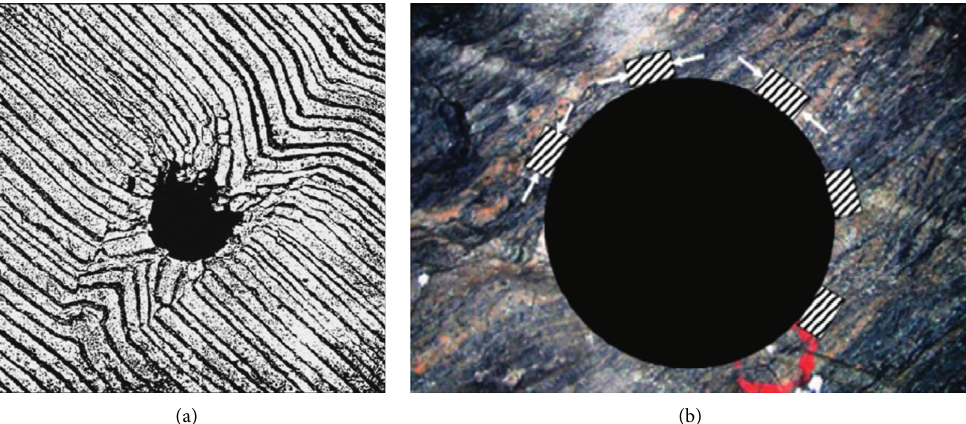
Figure 1: Failure mode and stress state of layered rock surrounding a wellbore or tunnel. (a) Wellbore failure in areas of steep, thin circulating zones [1]. (b) Stress states around a tunnel in a layered rock mass